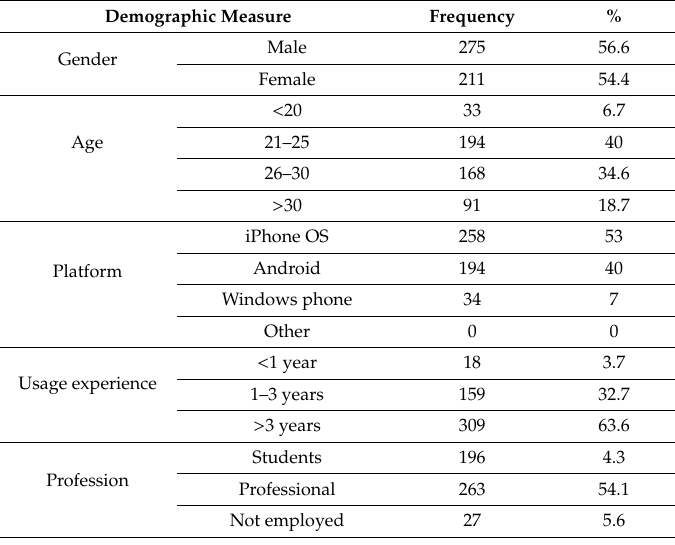
Table 3. Descriptive statistics of